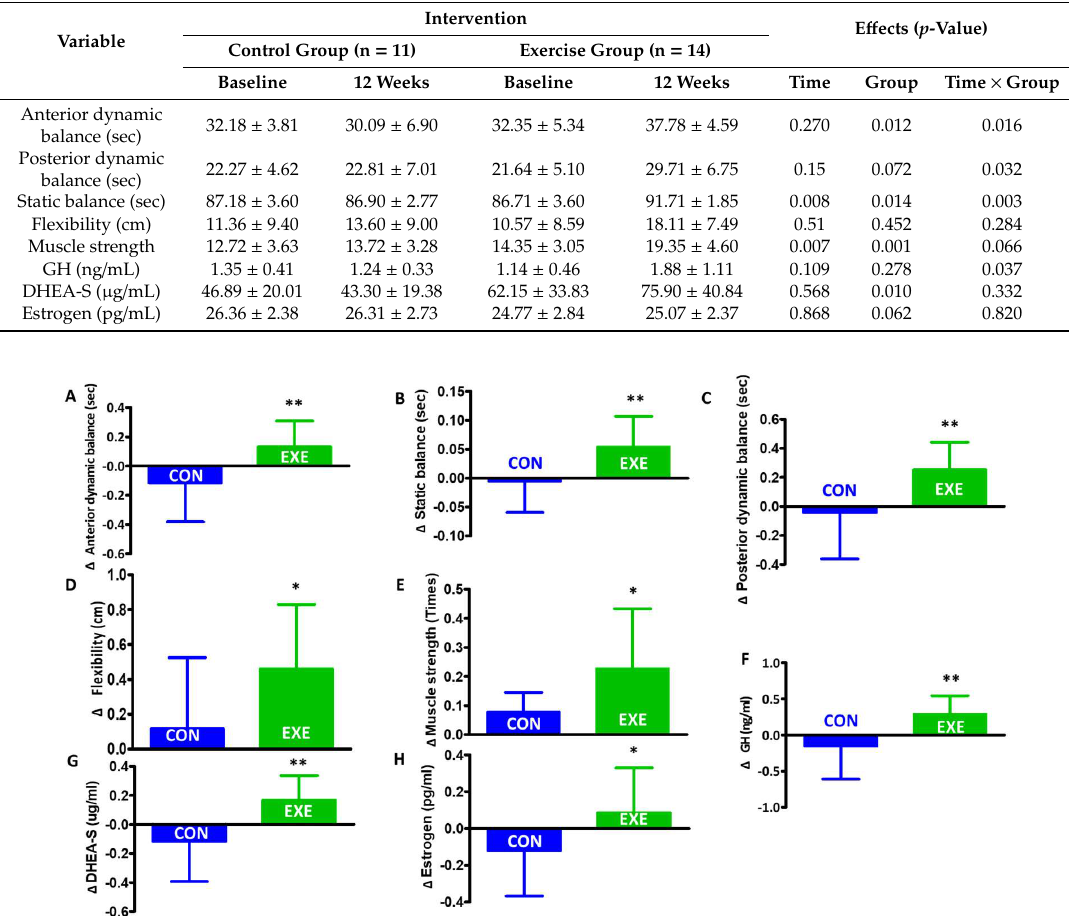
Figure 2. Changes in anterior dynamic balance, posterior dynamic balance, static balance, flexibility, muscle strength, growth hormone (GH), dehydroepiandrosterone-sulfate (DHEA-S), and estrogen from baseline to 12-weeks post-intervention in the control (CON) or exercise (EXE) group. * p < 0.05 compared to CON, ** p < 0.01 compared to CON. Values are presented as mean ± SD. ( A ) anterior dynamic balance ( p = 0.009), ( B ) posterior dynamic balance ( p = 0.008), ( C ) static balance ( p = 0.010), ( D ) flexibility ( p = 0.040), ( E ) muscle strength ( p = 0.030), ( F ) GH ( p = 0.040), ( G ) DHEA-S ( p = 0.003), and ( H ) estrogen ( p =